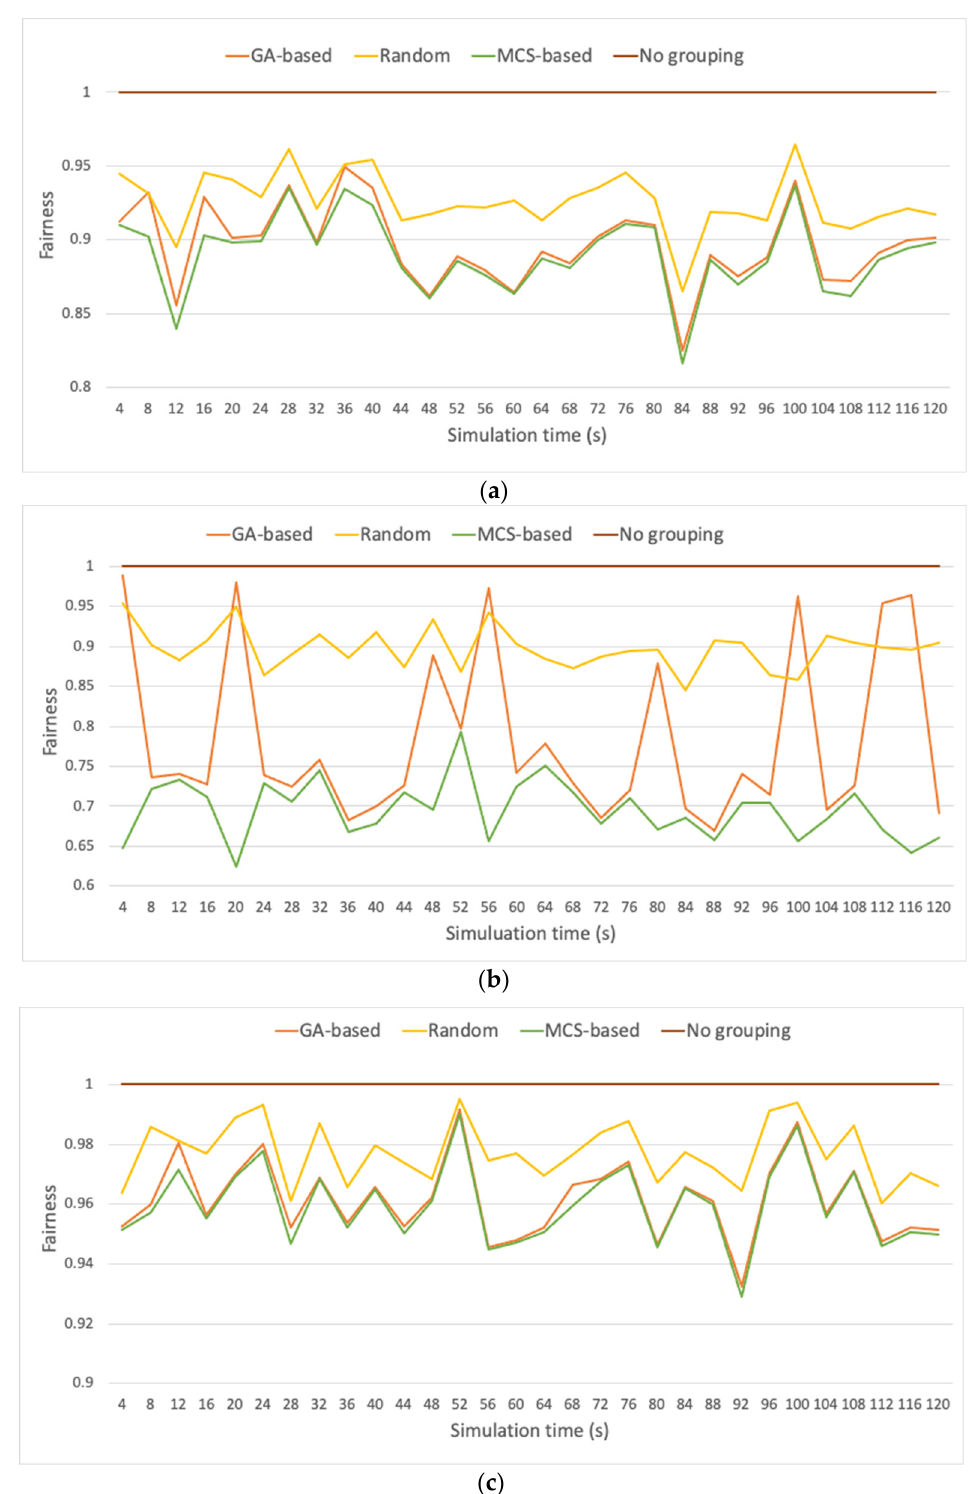
Figure 21. Throughput performance for scenario with STAs with ( a ) MCSs uniformly distributed, ( b ) MCSs distributed with 50% probability of being the slowest MCS (i.e., MCS 10), and 50% prob- ability of being any of the remaining MCSs (MCS 0 to MCS 9), and ( c ) MCSs distributed with 50% probability of being the fastest MCS (i.e., MCS 9), and 50% probability of being any of the remaining MCSs.